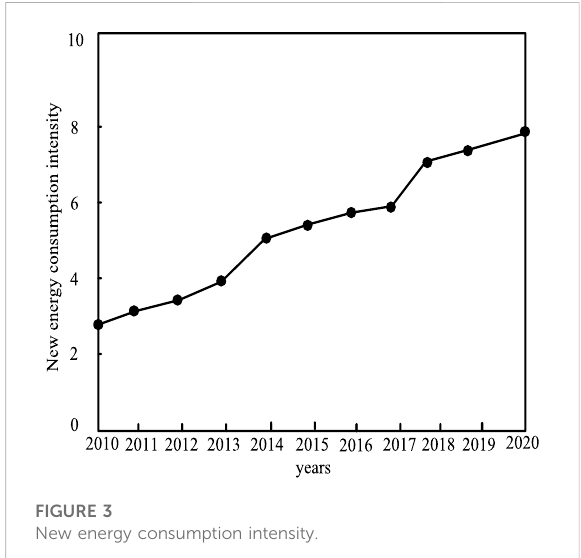
FIGURE 3 New energy consumption